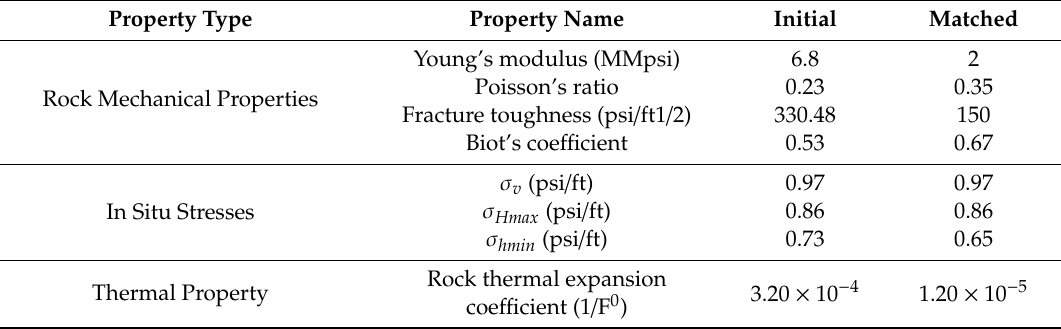
Table 3. Initial and Final Matched Geomechanical and Thermal